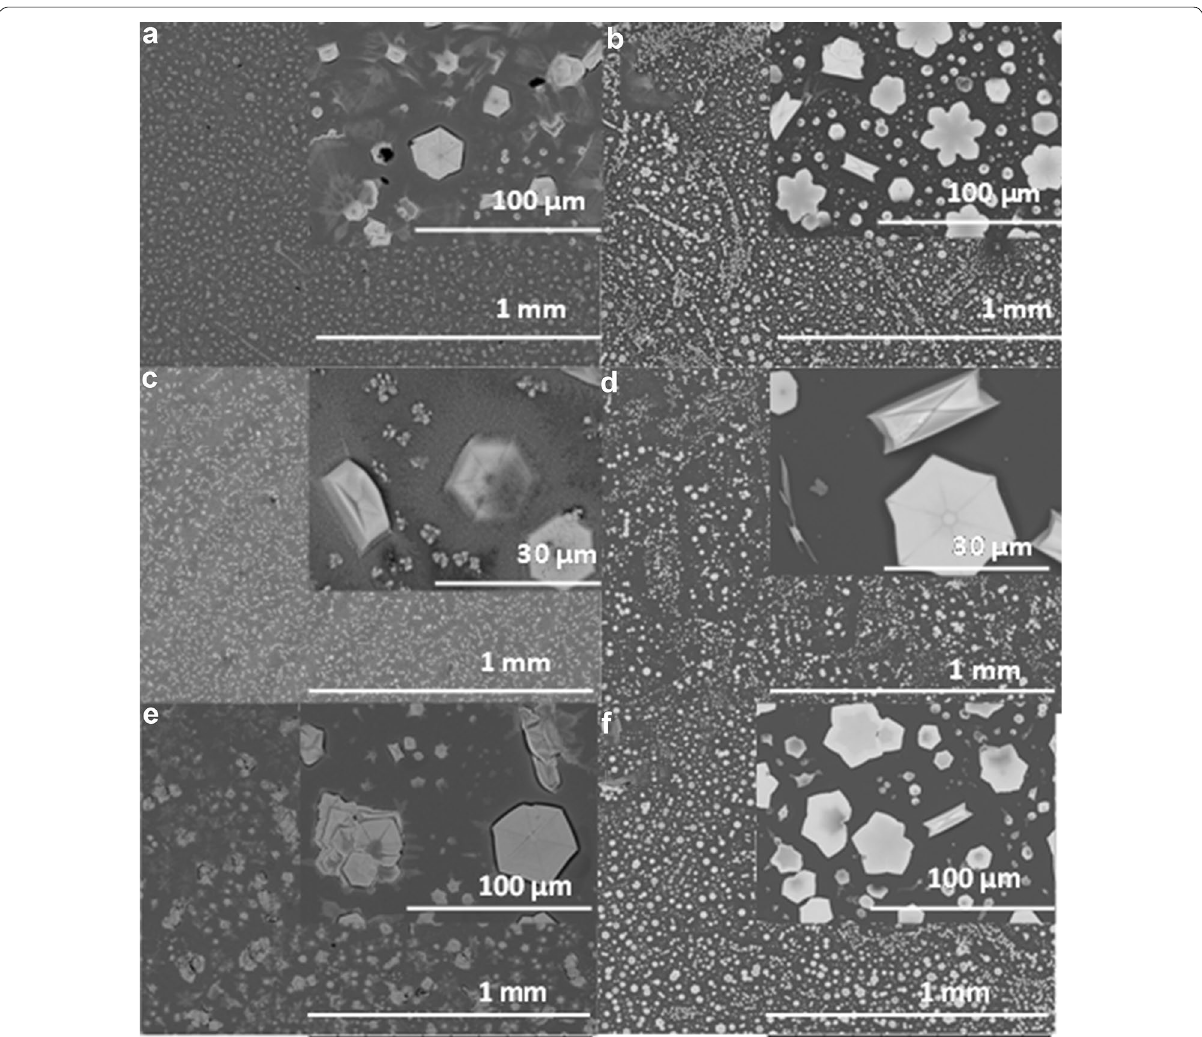
(Table 1), there are missing points of Bi on NiO layer (at the points 2 and 3 in Table 2). The points 2 and 3 out